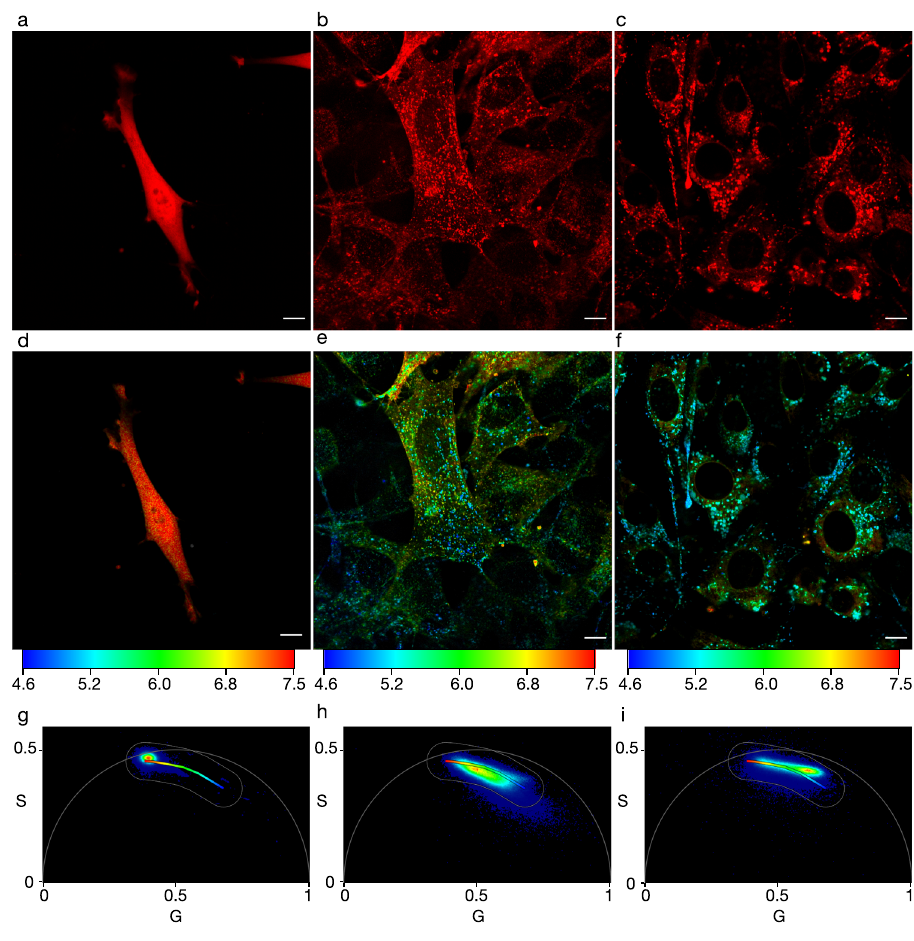
Fig. 2 | Fusing mApple to localisation tags enables the pH of different sub- cellular compartments to be visualised. a – c Confocal images of NIH-3T3 cells expressing cytosolic mApple ( a ), TfR-mApple ( b ), and TMEM106b-mApple ( c ), pseudo-colouredred. d – f CorrespondingfastFLIMimagesof a – c pseudo-coloured